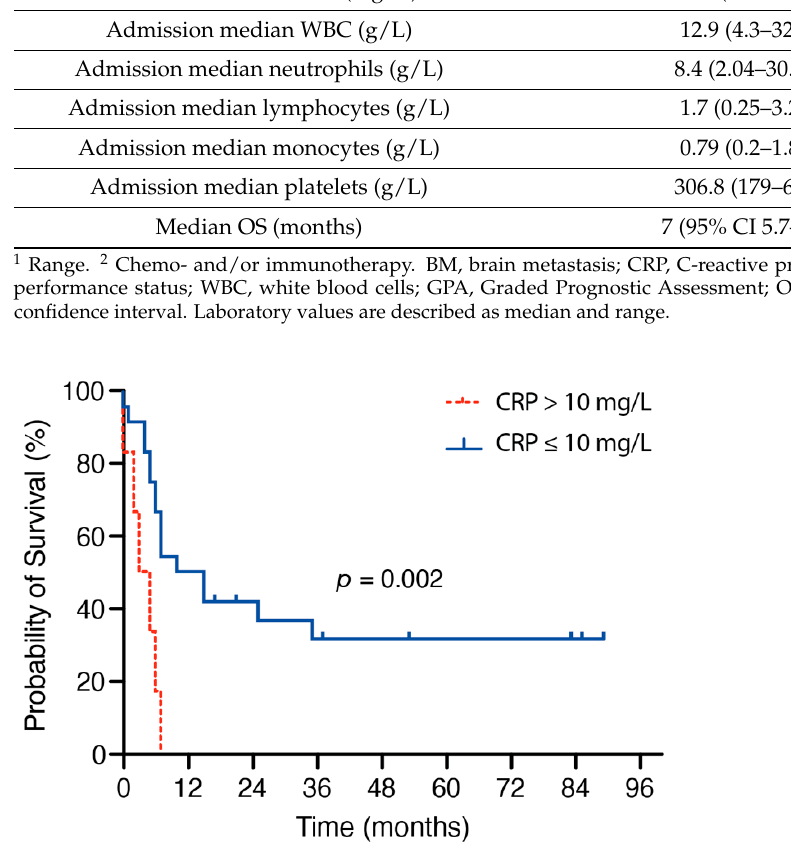
Figure 1. Kaplan–Meier curves for the association of preoperative CRP values and OS. CRP, C-reactive protein; OS, overall survival.